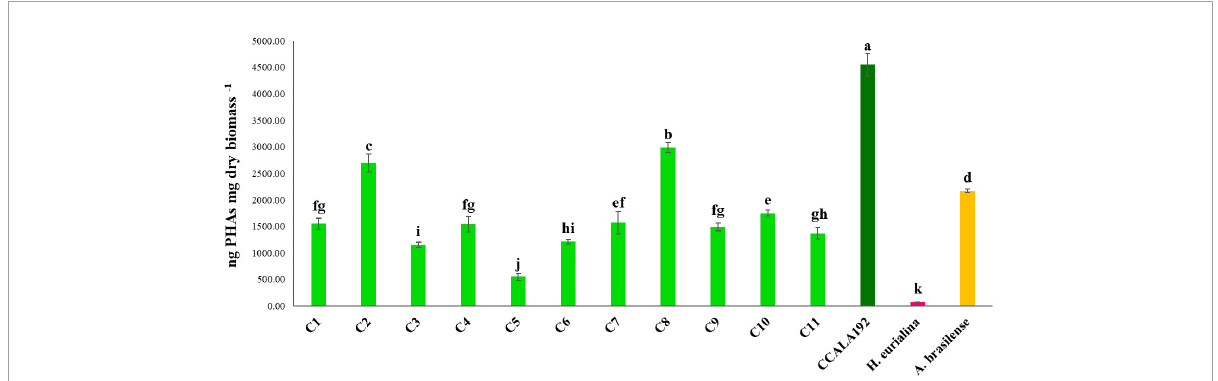
FIGURE5 Polyhydroxyalkanoates contents recorded for “Stiffe” caves’ cyanobacteria and Synechocystis cf. salina , grown in BG11 modified for starvation, and for A. brasilense and H. eurihalina , cultured on NFCC and MH, respectively. Uppercase letters refer to the comparison among BG11 0 growths and A. brasilense and H. eurihalina. Lowercase letters refer to the comparison among BG11 starving growths and A. brasilense and H. eurihalina. For both conditions, results followed by the same case letters are not significantly different according to Fisher’s LSD post hoc test ( p > 0.05) (LSD value,